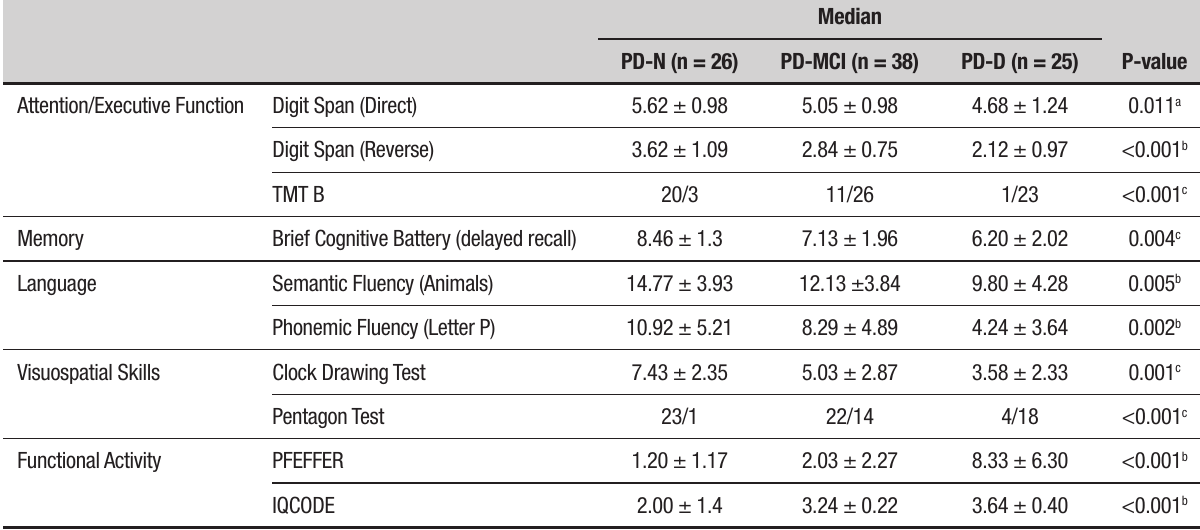
Table 2. Cognitive performance of Parkinson’s disease patients.